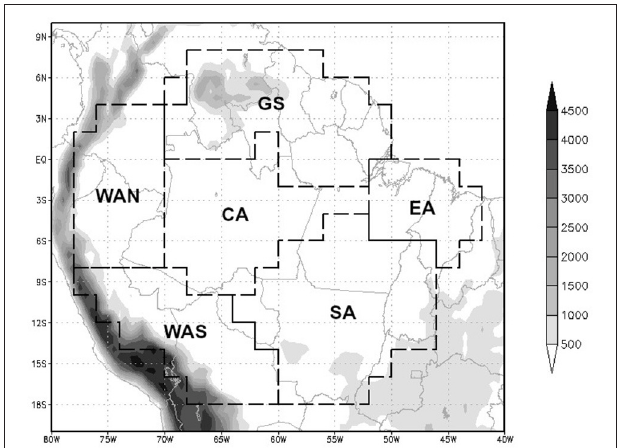
FIGURE 1 | Regions under study denoted by black dashed lines. WAS, southern part of western Amazonia; WAN, northern part of western Amazonia; GS, Guyana Shield; CA, central Amazonia; EA, eastern Amazonia; SA: southern Amazonia (Adapted from ter Steege et al., 2013). Shading indicates topography in meters. Light gray contours indicate political boundaries for countries and Brazilian